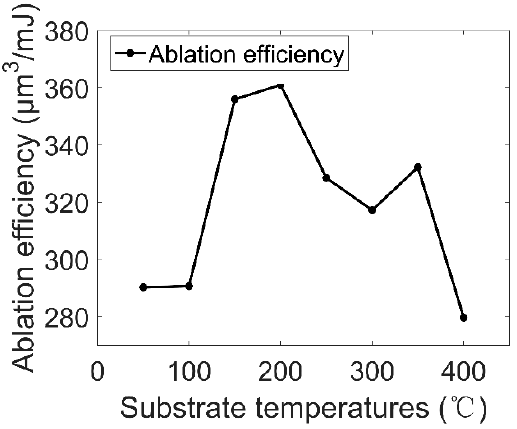
Figure 16. Ablation efficiency ω after 32 pulses irradiation at substrate temperatures of 50–400 °C.